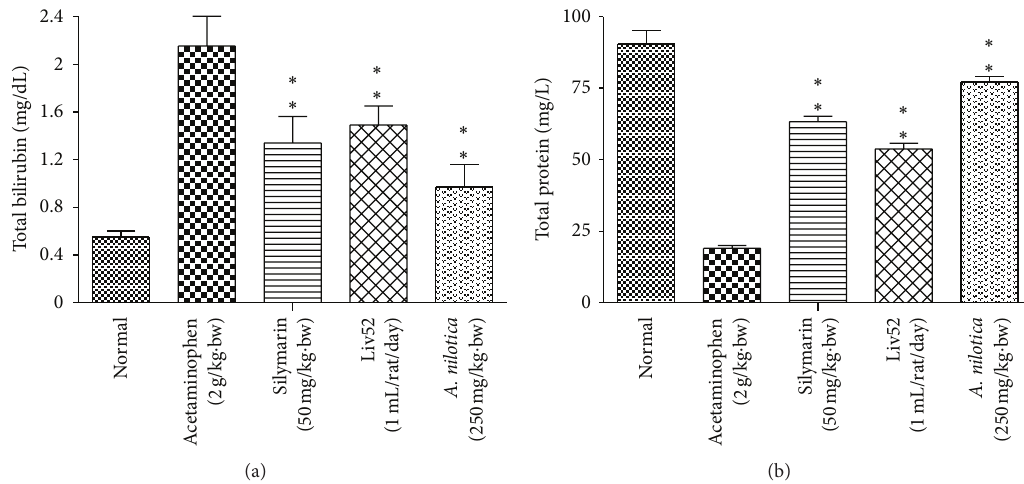
Figure 2: Effect of the methanolic extract of A. nilotica (250mg/kg ⋅ bw) on total bilirubin (mg/dL) and total protein levels (mg/L) in acetaminophen-treated animals. Values shown are the means ( ± SD) of 6 mice/treatment group. Values are significantly different from acetaminophen-treated (nonextract-treated) control, ( ∗ 𝑃 < 0.05 , ∗∗ 𝑃 < 0.01